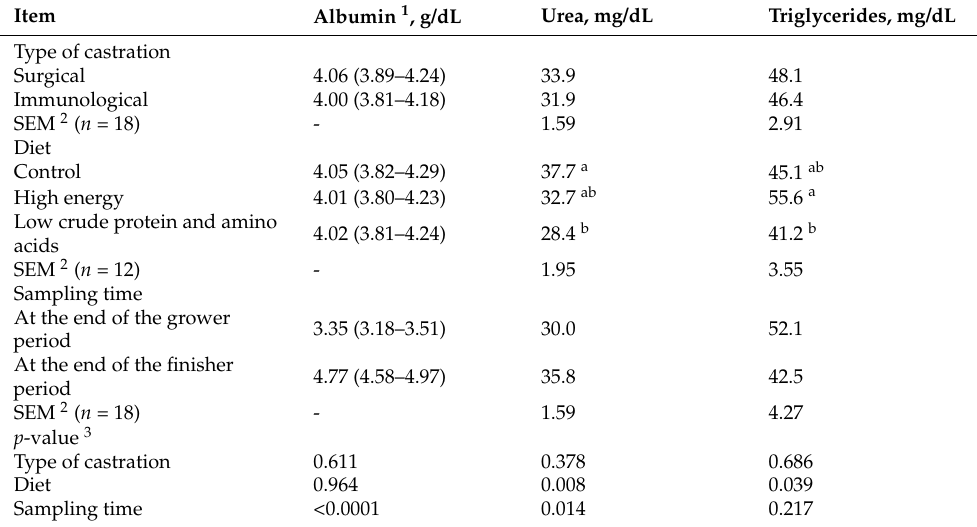
Table 4. Impact of type of castration, diet and sampling time on serum metabolites (least square means) of heavy male